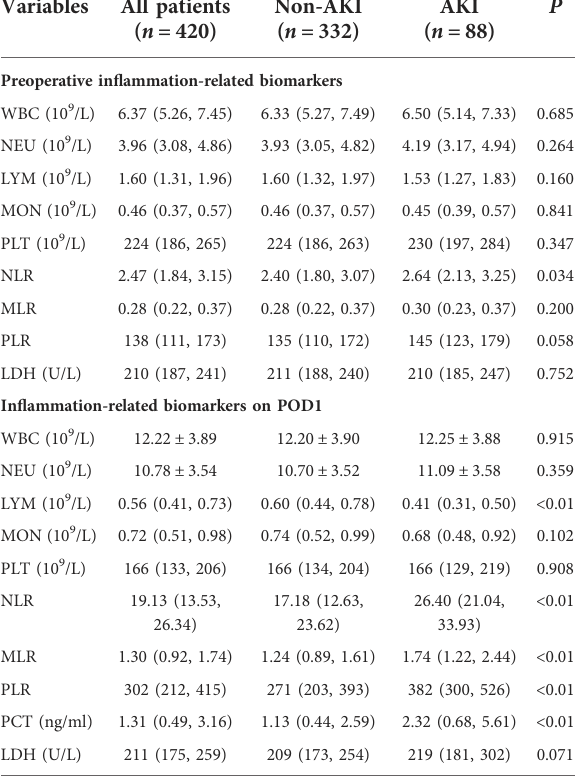
TABLE 3 In fl ammation-related biomarkers in the non-AKI and AKI group.